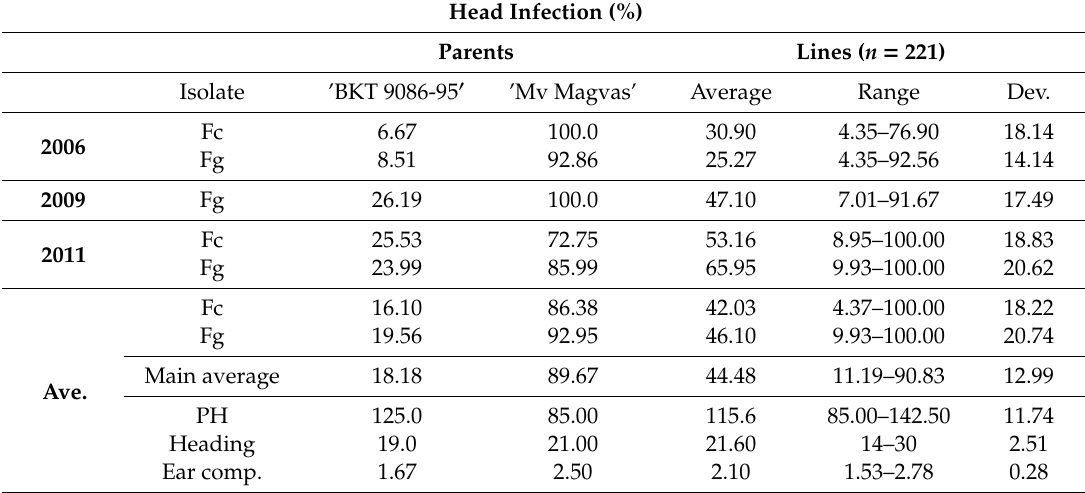
Table 3. Average field infection values of the lines and parental genotypes ( n = 223, Martonv á s á r, 2006, 2009,